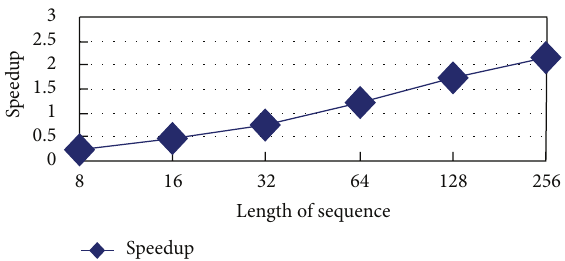
Figure 2: The speedup of GPU parallel